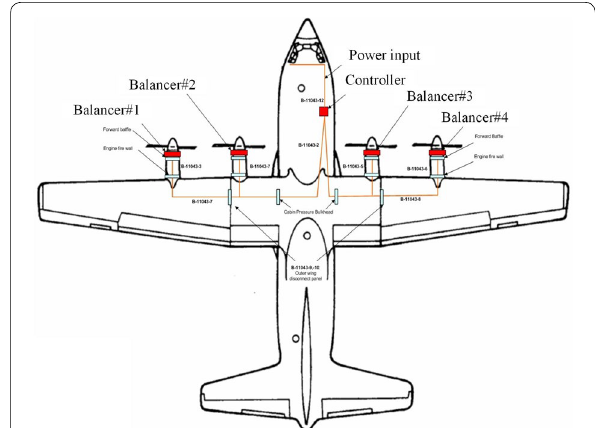
Figure 4 Installation diagram of the automatic balancing system